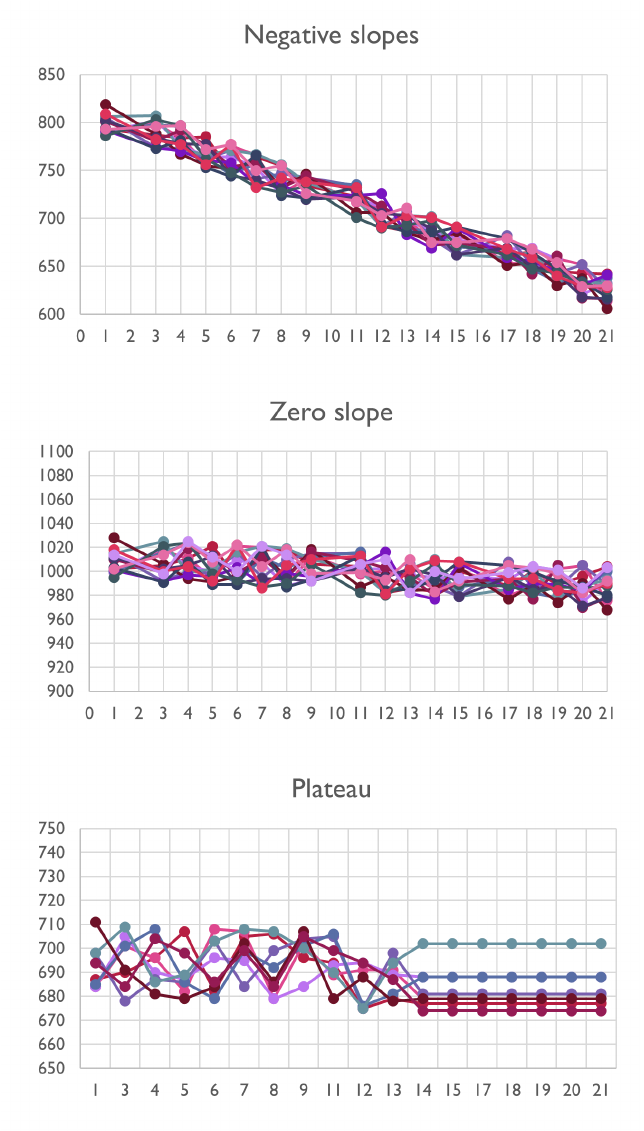
Figure 5. Academic growth trajectories in the simulated